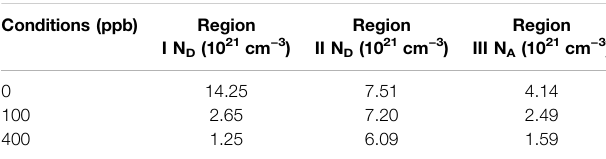
TABLE 1 | Calculated defect densities in oxide layers formed in different Zn solutions. Conditions